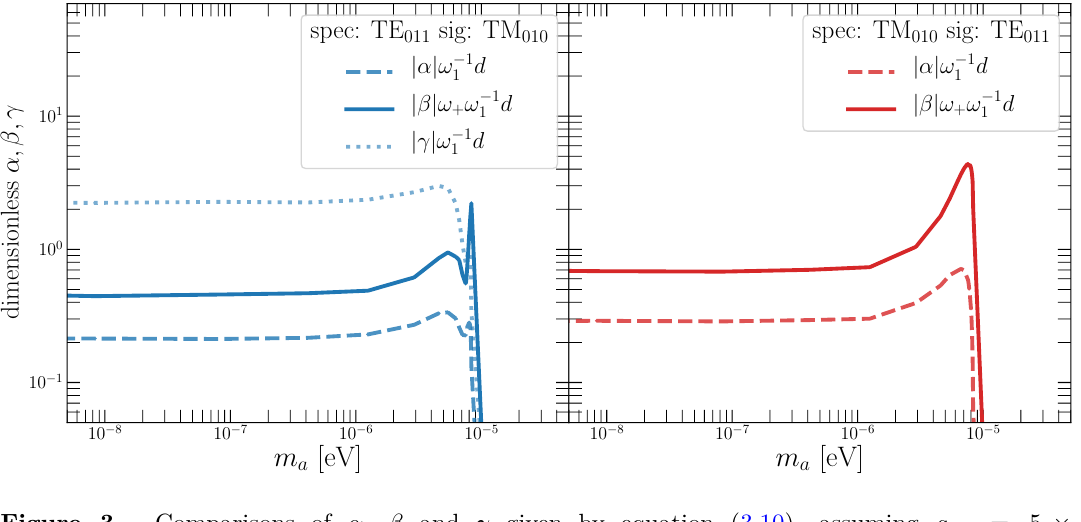
Figure 3 . Comparisons of α , β and γ given by equation (3.10), assuming g aγ = 5 × 10 − 11 GeV − 1 , E peak = 80MV / m . ω + = ω 011 + ω 010 , ω 1 is the frequency of the signal mode for TE TM each detector. Production and detection cavities are cylindrical with R = L = 0 . 1766m , and are aligned in z with (0 . 1m + L) between their